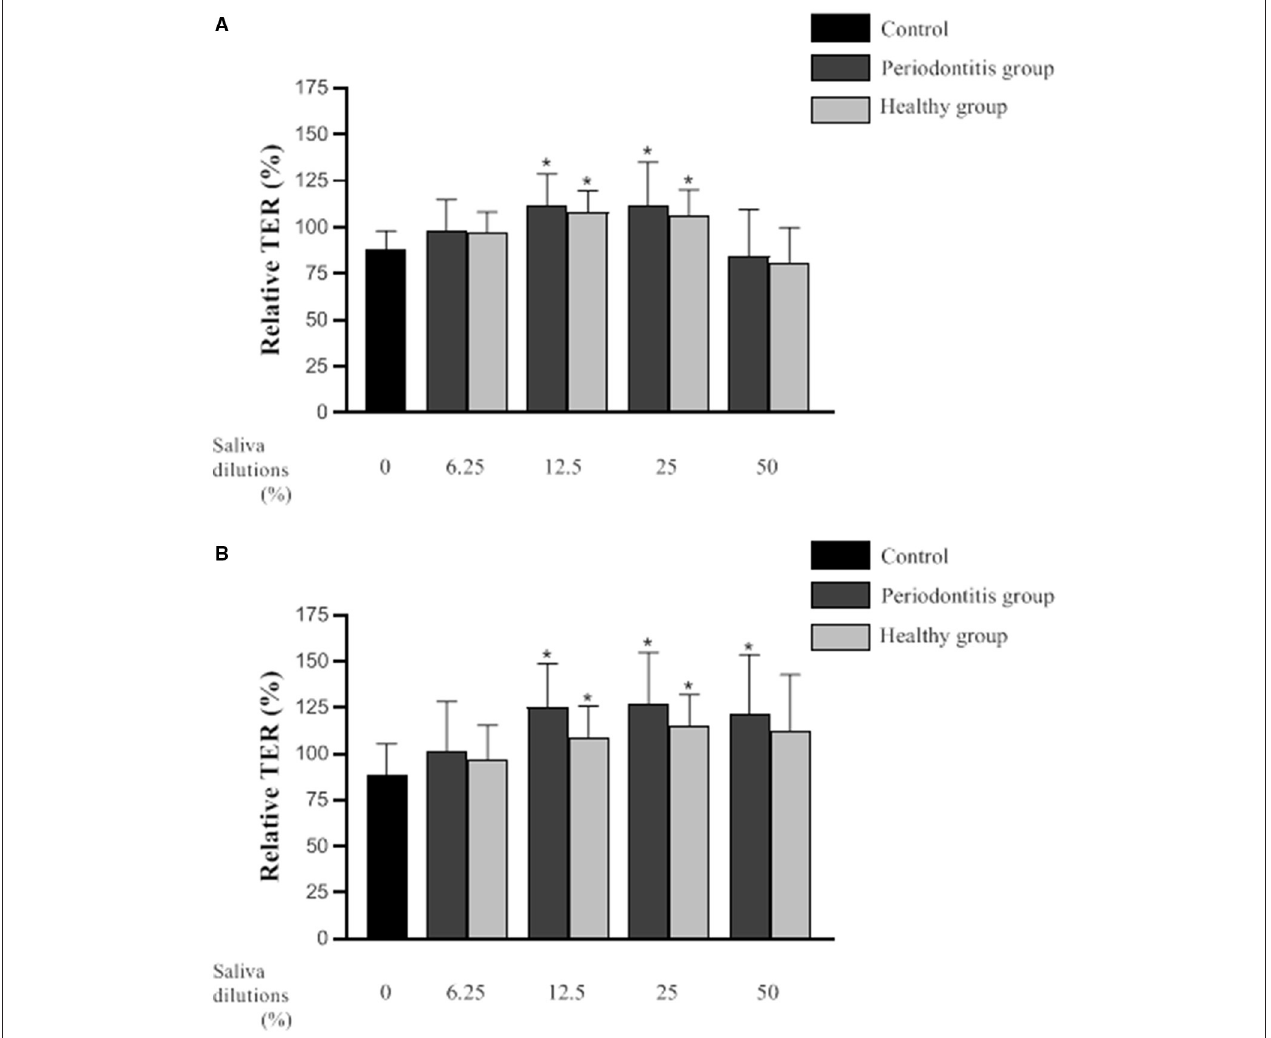
FIGURE 3 | Effect of various dilutions of filter-sterilized saliva from the periodontitis and healthy subjects on the relative transepithelial electrical resistance (TER) of an epithelial barrier model following a 3-h (A) and 6-h (B) exposure. Data are expressed by group as the mean ± SD of the relative TER determined in triplicate assays. A difference with the control group was considered significant at p < 0.05 (*). No significant difference s ( p < 0.05) were observed between the periodontitis and health y subjects at any saliva dilution or time